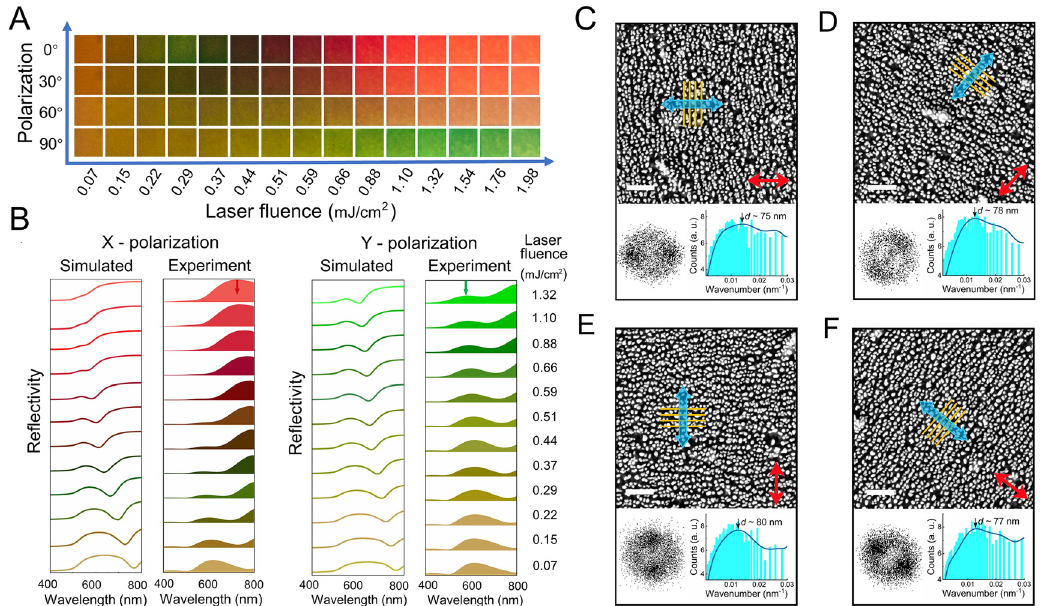
Figure 2: Polarization sensitive structural color and nanogratings created induced by femtosecond laser pulses with different fluences and polarizations. (A) Tunable color palettes obtained by irradiating the sample surfaces with femtosecond laser pulses of different fluences and illuminated them with white light of different polarizations. (B) Reflection spectra measured and calculated for nanostructures induced by femtosecond laser pulses with different fluences and irradiated by using white light with polarization angles of 0 ° and 90 ° . The red and green arrows indicate the re fl ection peaks appearing in the re fl ection spectra of the nanogratings fabricated at high laser fl uence and irradiated by using white light with polarization angles of 0 ° and 90 ° . SEM images of the nanogratings induced by using femtosecod laser light with polarization anglesof0 ° (C),45 ° (D),90 ° (E)and135 ° (F),respectively.Ineachcase,theorientationofthenanogratingisindicatedbyparalleledyellowlines. The vector of the nanograting and the polarization of the laser light are marked by blue and red arrows, respectively. In addition, the Fourier transformation of the SEM image, which shows the orientation and period of the nanograting, is also provided as an inset. The length of the scale bar is 300